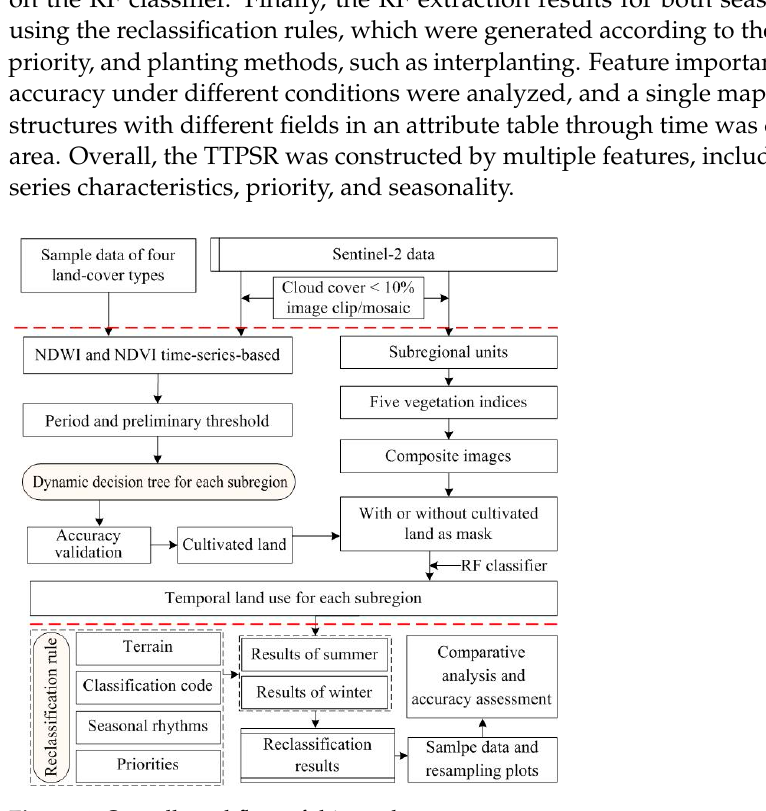
Figure 4. Overall workflow of this study.